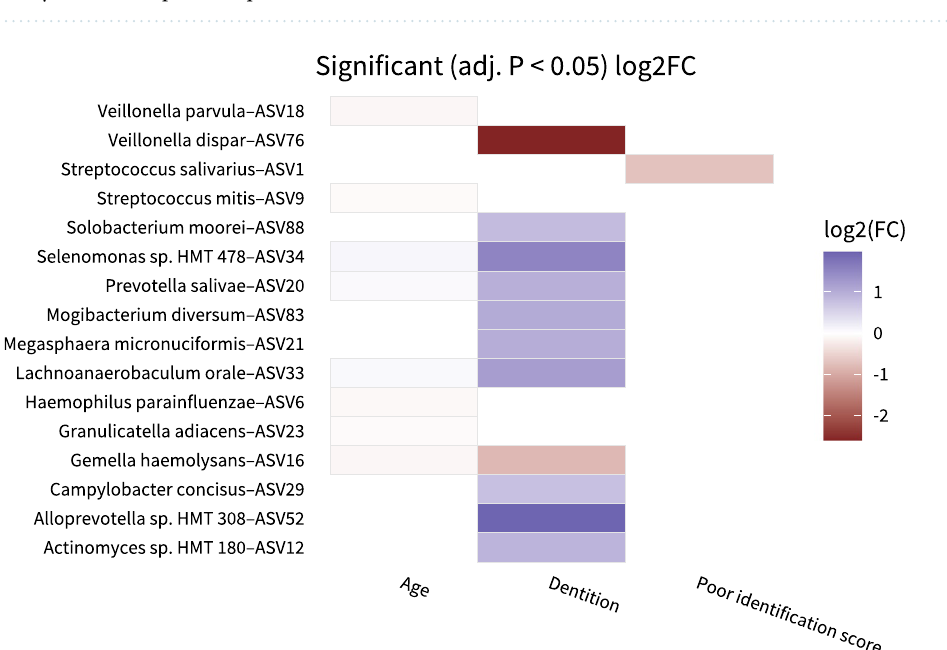
Figure 3. Canonical correspondence analysis of microbiota with poor taste, smell, appetite, and undernutrition. Canonical correspondence analysis depicting the species that most drive the correlations of the microbiota with poor appetite and undernutrition, or poor taste and poor smell. Poor appetite and poor smell identification are significantly associated with the microbiota data (CCA p = 0.010 and p = 0.001, respectively). Species are incorporated in the plot according to the interquartile rule, i.e. if their distance from the null-point (0,0) is greater than (1.5·IQR) + Q3 (in which IQR = Interquartile Range and Q3 = the third quartile). Species names corresponding to ASV numbers can be found in Supplementary Table S3. CCA Canonical correspondence analysis, ASV Amplicon sequence variance.